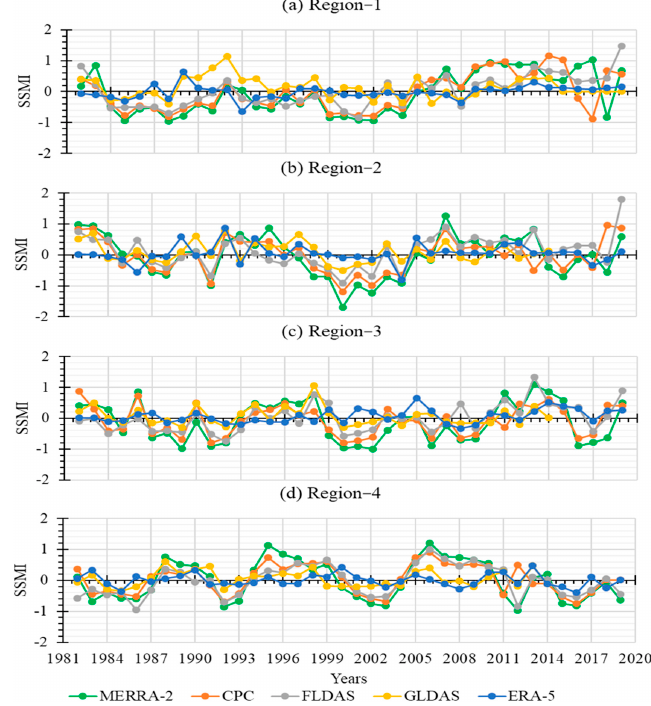
Figure 4. ( a – d ) Temporal assessment of standardized soil moisture index data over the study region. Temporal valuation interpreted in conjunction with Table 2.